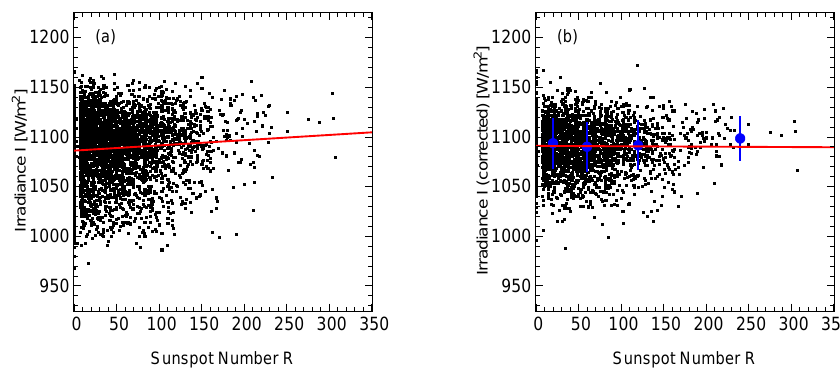
Fig. 6. (a) Irradiance I of the solar beam (pyrheliometry) versus sunspot number for Cerro Montezuma and airmass 1.5, showing a very similar trend to the one presented in Fig. 1 of W10. The linear slope has a value of + 0 . 053 ± 0 . 030. (b) Same as before, but for the corrected values of the pyrheliometry, i.e. with the deviation of the monthly medians from the annual average subtracted to correct for seasonal variations, and without the data from years affected by volcanic aerosols or local pollution. The red line indicates a linear regression to the data, showing no statistically significant trend with sunspot number (slope − 0 . 0039 ± 0 . 0340). The blue circles and their error bars illustrate median values and the variance in four sunspot-number intervals.